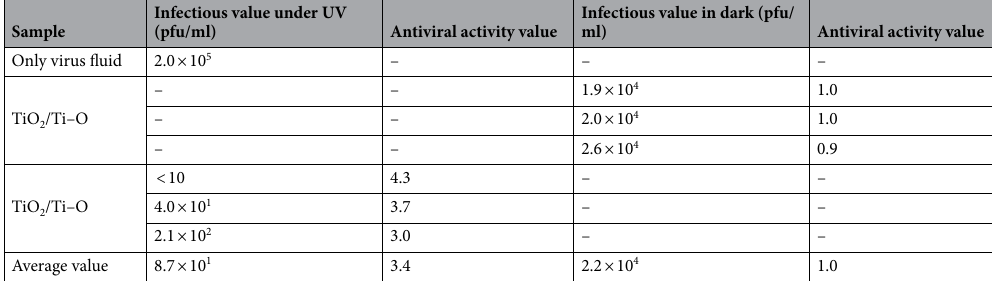
Table 1. The infectious value and antiviral activity value of the samples, under UV irradiation (0.25 mW/cm 2 ) and in dark.